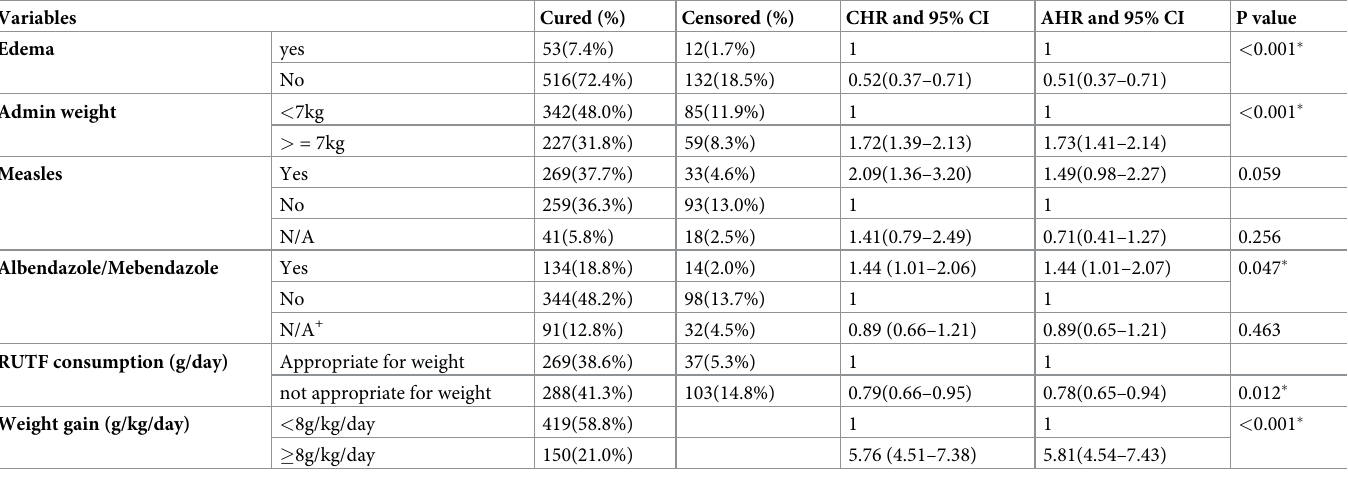
Table 7. Multivariate Cox-regression for prediction of time to recovery from SAM under OTP in Dire Dawa, Ethiopia; from January, 2013 to December,